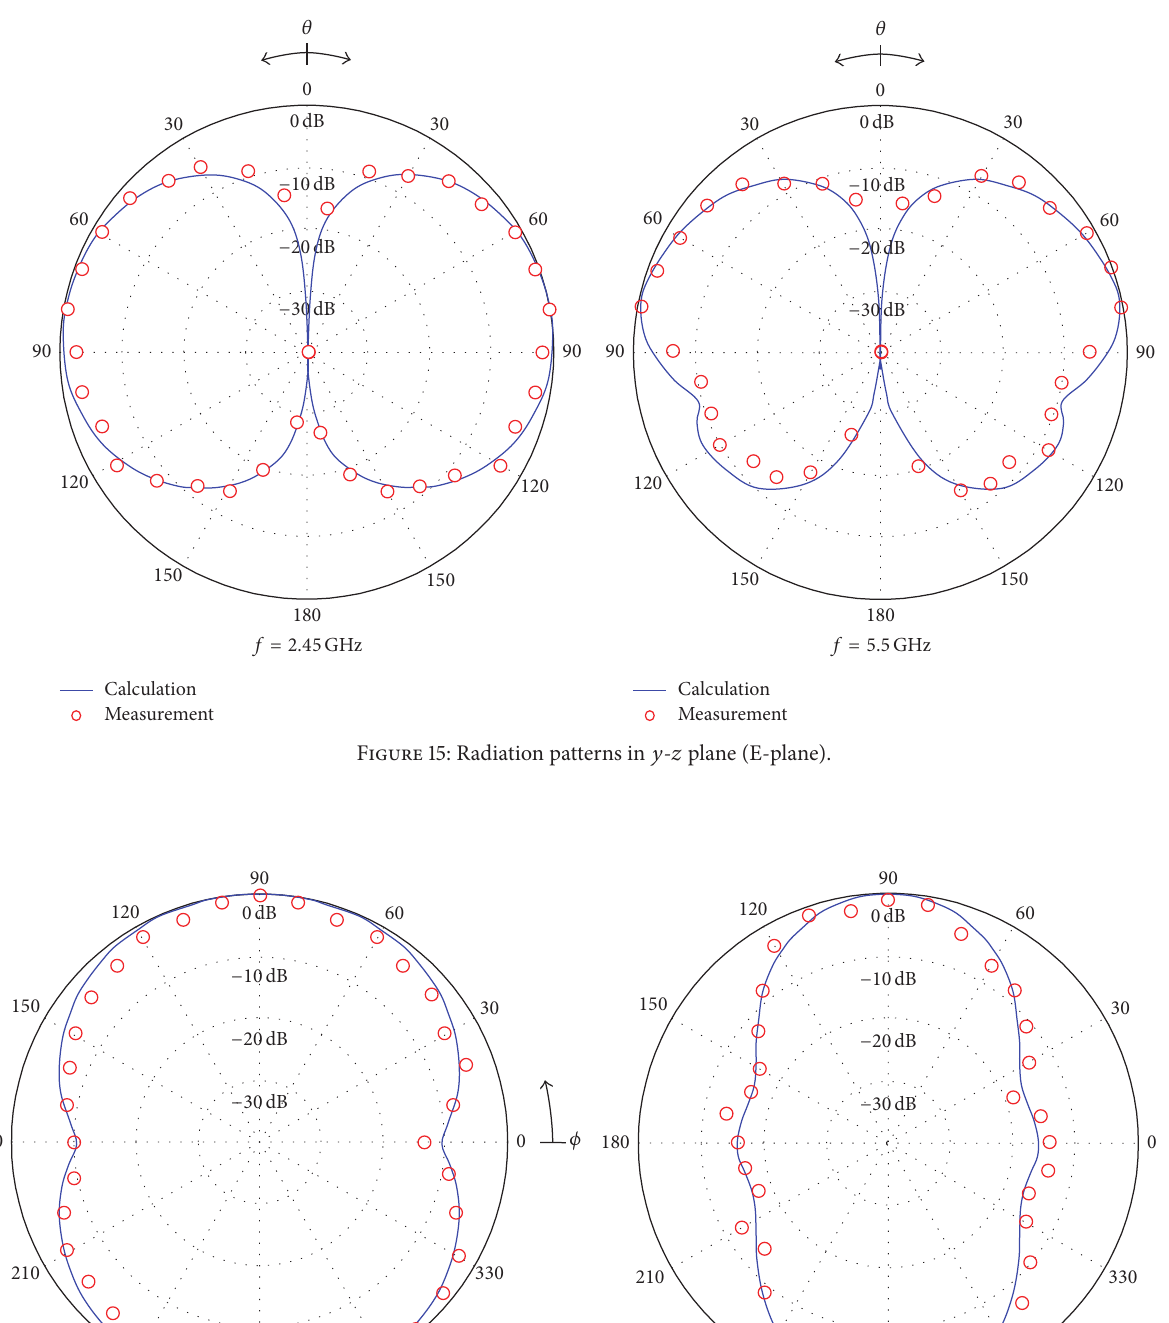
Figure 16: Radiation patterns in 𝑥 - 𝑦 plane